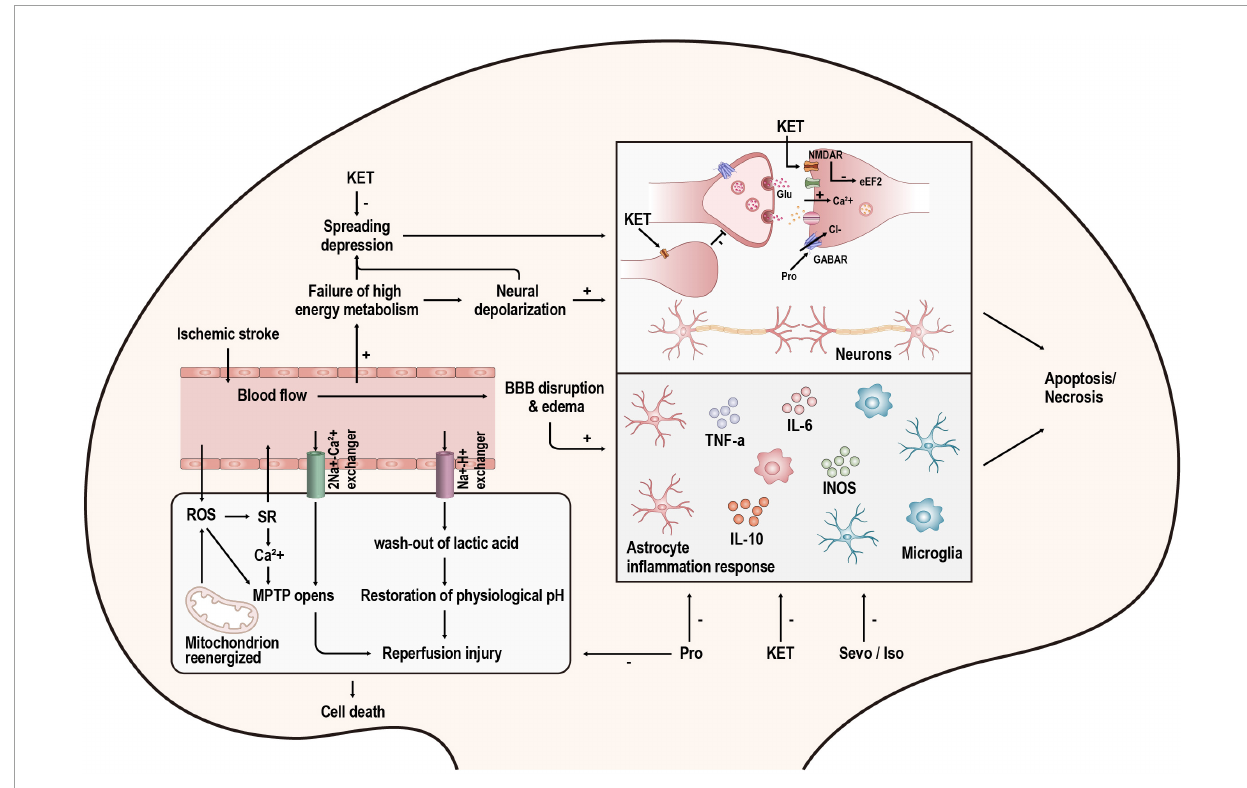
FIGURE2 Overview of the mechanisms of injury after stroke and the targets of anesthetics. KET, ketamine; Pro, propofol; Sevo, sevoflurane; Iso, isoflurane.